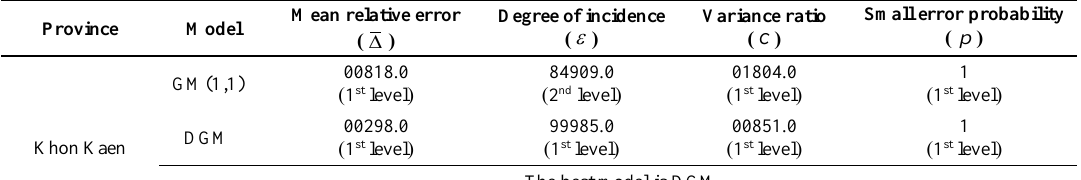
Table 5. The model accuracy testing of GM(1,1) and